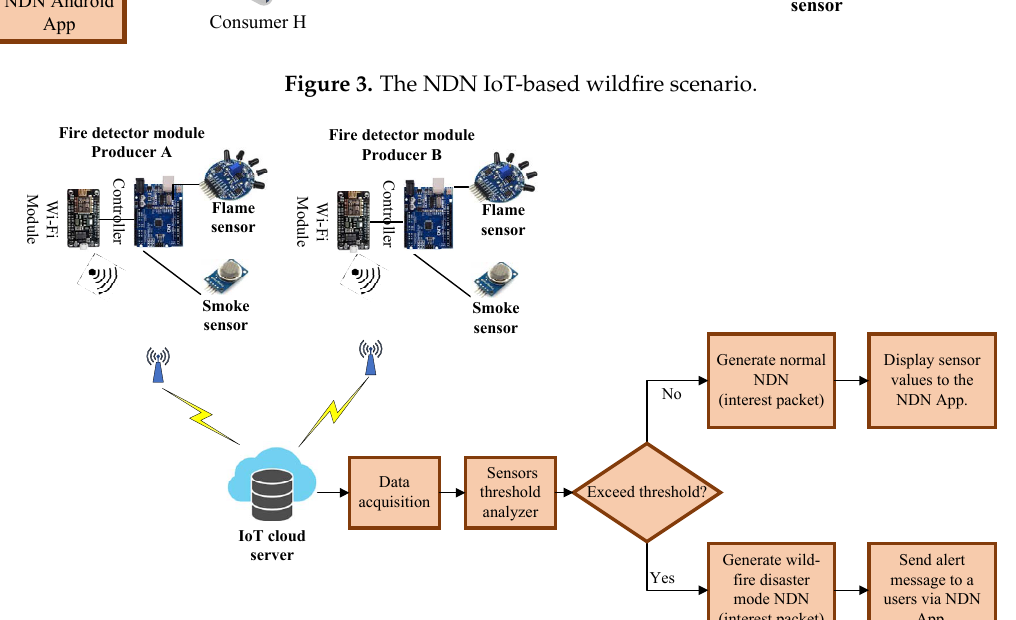
Figure 3. The NDN IoT-based wildfire scenario.